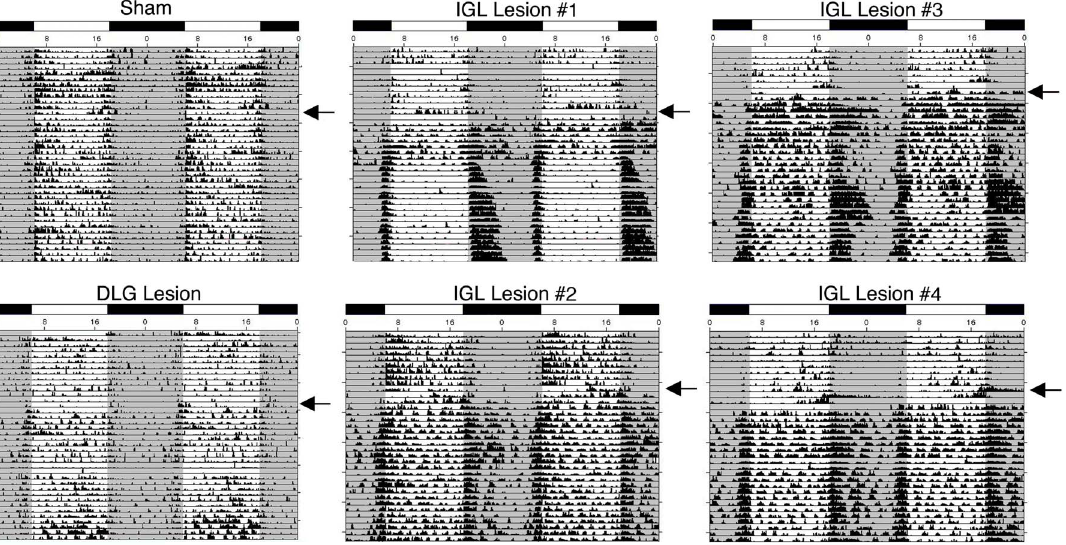
Figure 3. Effects of lesions on behavior before and after surgery in LD conditions. Actograms depicting general activity before and after surgery in representative animals with sham lesions (top left), a miss (DLG lesion, bottom left), and complete IGL lesions (records from 4 such animals are shown in the middle and right columns). Lesion size for the representative DLG lesion (i.e., miss) and IGL Lesion # 1 are presented in Figure 2. Day of surgery is indicated by the black arrow. White/black bar indicates the 12:12 hour light/dark cycle. Note the lack of change in activity patterns in the sham and DLG lesion following surgery. In contrast, there is a significant increase in nighttime activity in IGL lesioned animals following surgery.